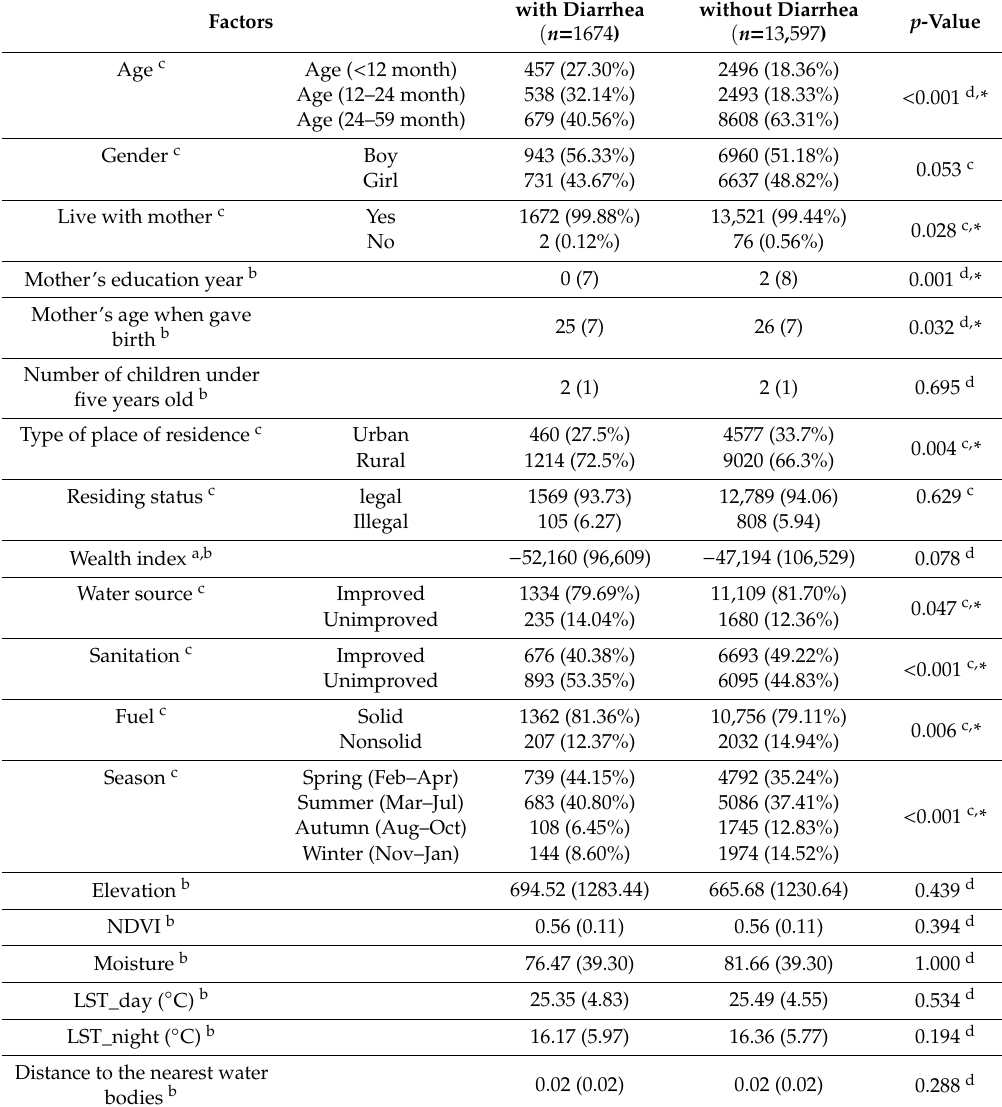
Table 3. Comparison of potential risk factors between children under five years old with and without